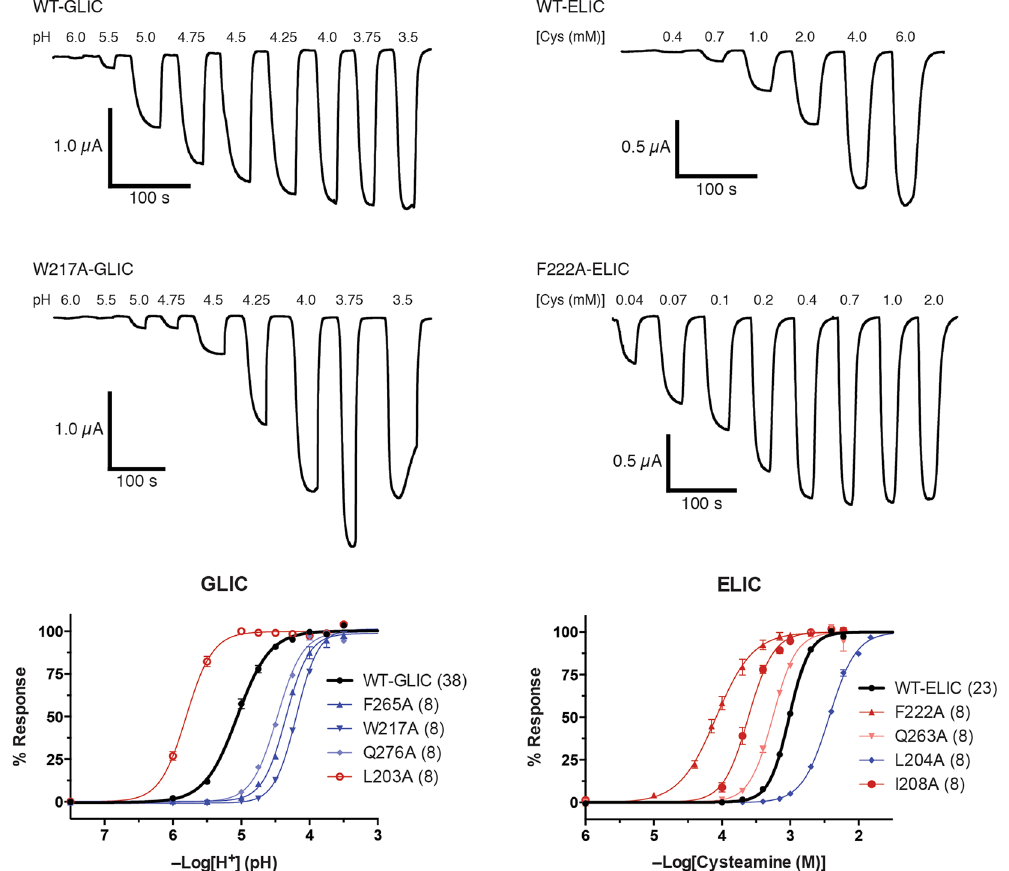
Figure 2. Functional characterization of the GLIC and ELIC mutants. Whole cell electrophysiological traces were recorded using two-electrode voltage clamp electrophysiology. Currents were recorded from Xenopus laevis oocytes expressing either GLIC (Left panel) or ELIC (Right panel) in response to protons or cysteamine, respectively. The lower panels presents dose response curves (normalized current (I/I max ) versus ligand concentration) for select Ala mutants, with the number (n) of averaged traces. Error bars represent